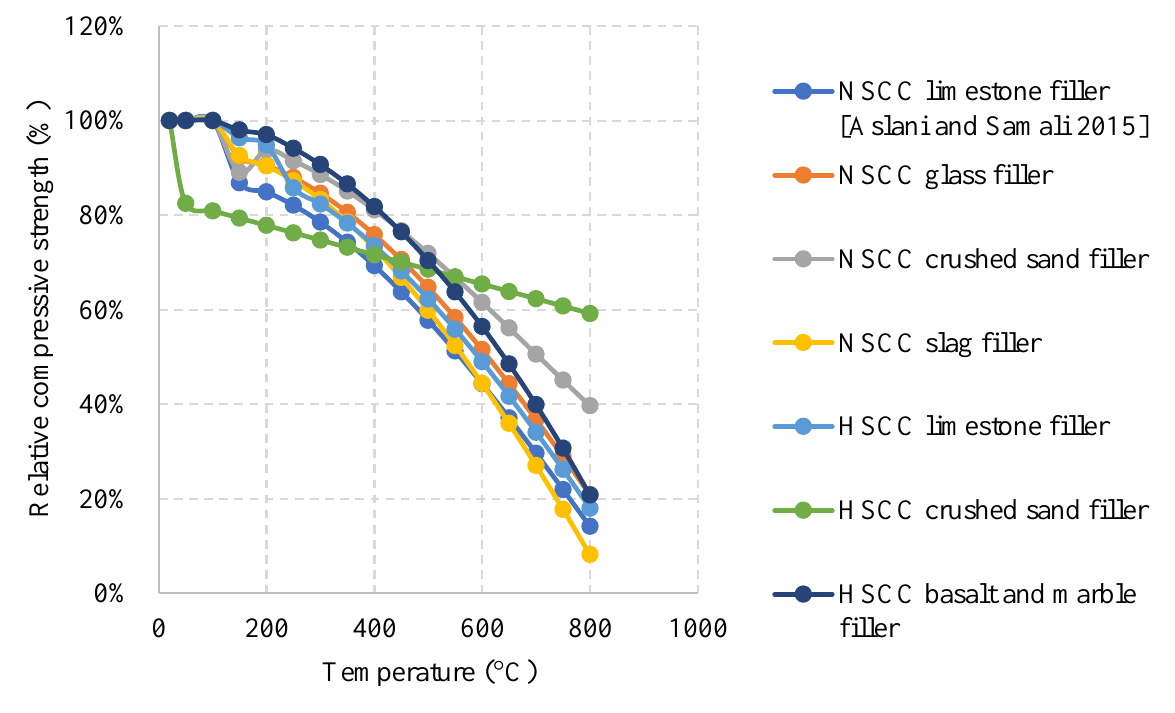
Figure 50. Relative tensile strength models for different types of concrete 2 [100].